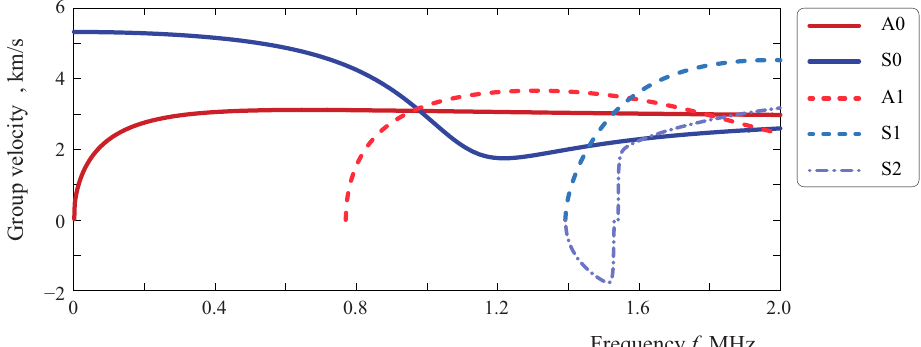
Figure 4. Group velocities of Lamb waves in a 2 mm thickness aluminum plate.